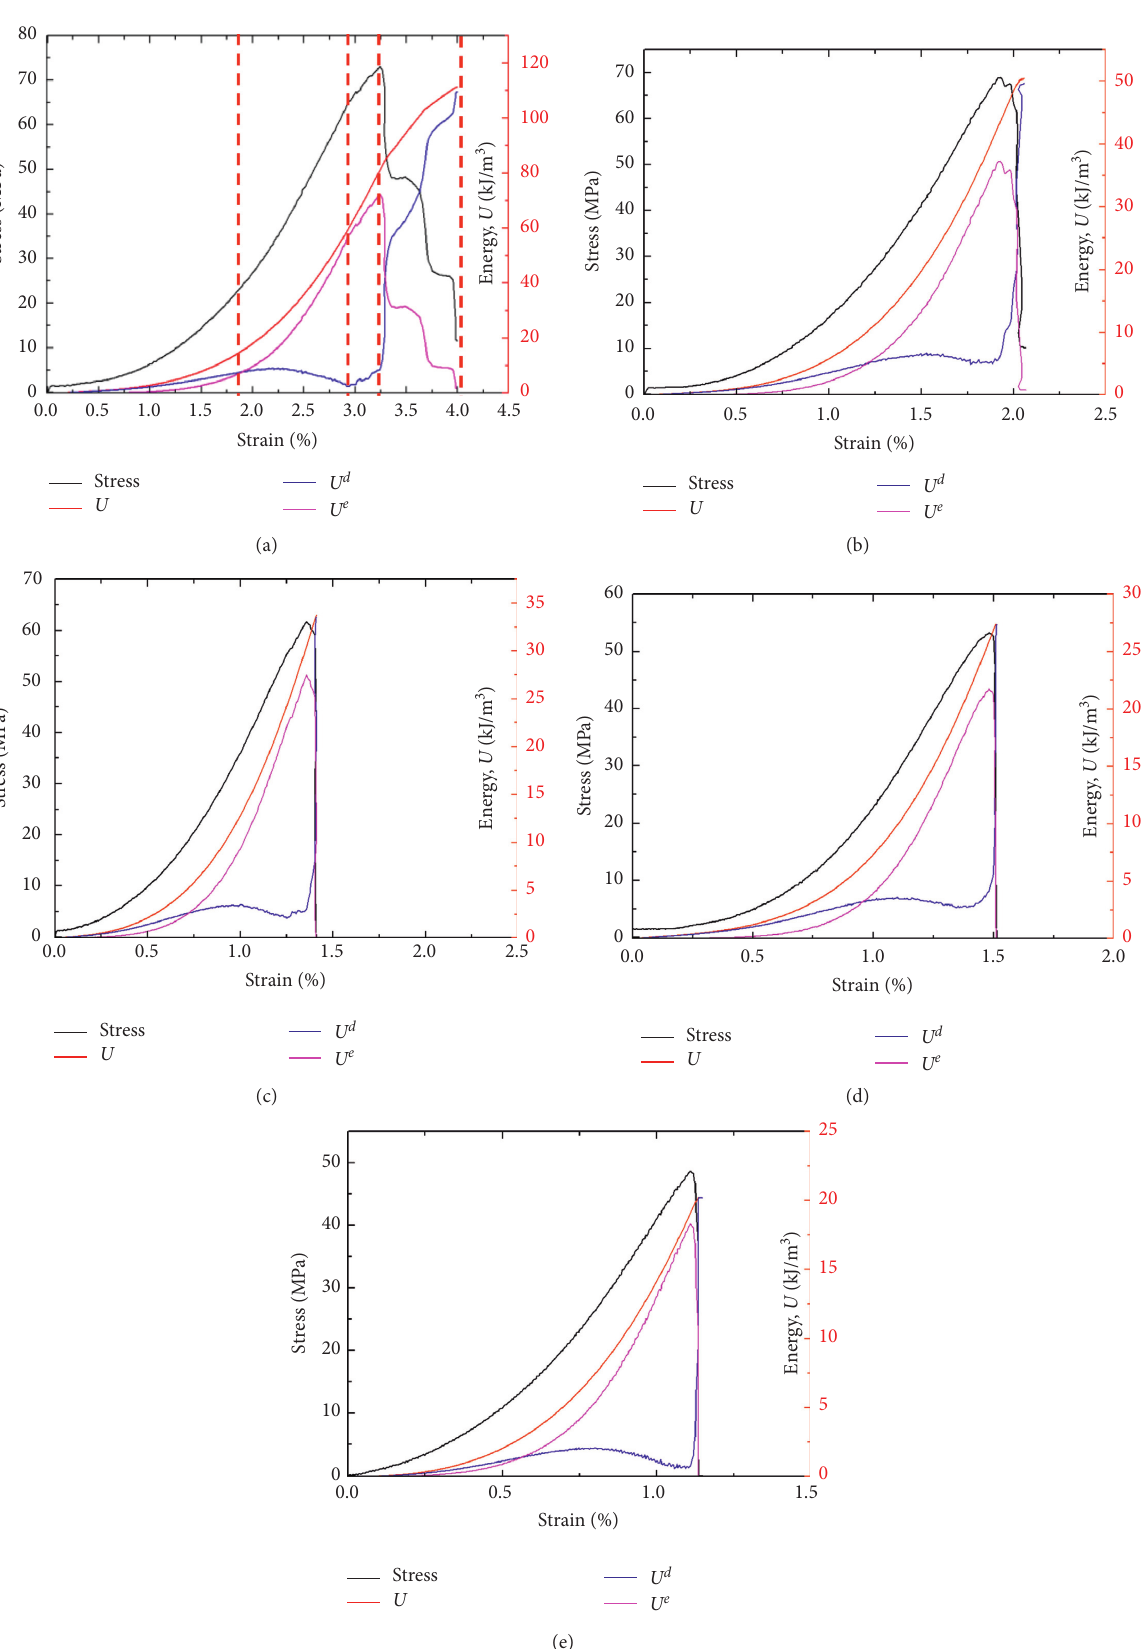
Figure 9: Energy evolution curves under stress at different slenderness ratios. (a) D � 0.5. (b) D � 1.0. (c) D � 1.5. (d) D � 2.0. (e) D �